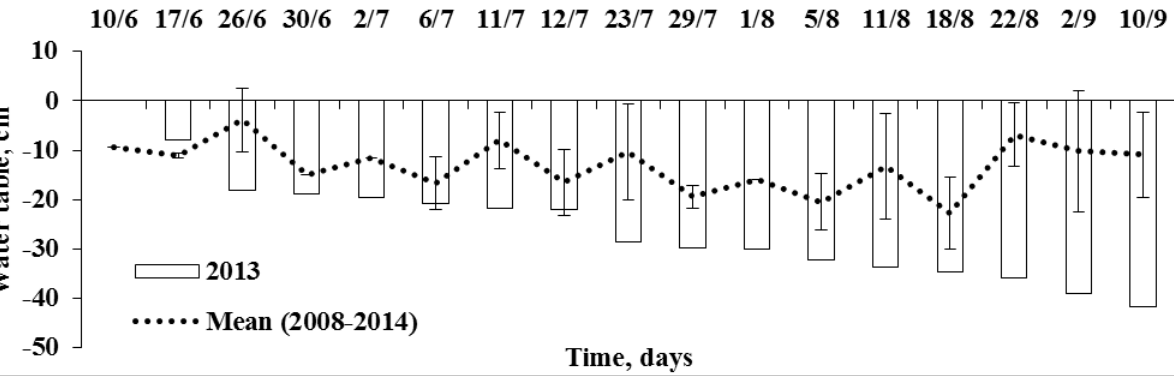
Figure 4. Seasonal course of water table level (WT) relative to ground surface level during the measurement period (10 June to 10 September) of 2013. The mean values are means of WT for six years (2008–2014 excluding 2012). The error bars show ± SD (standard